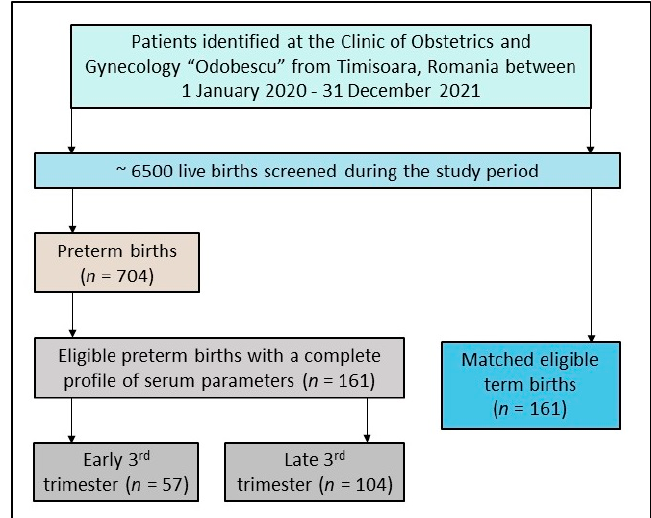
Figure 1. Patient selection